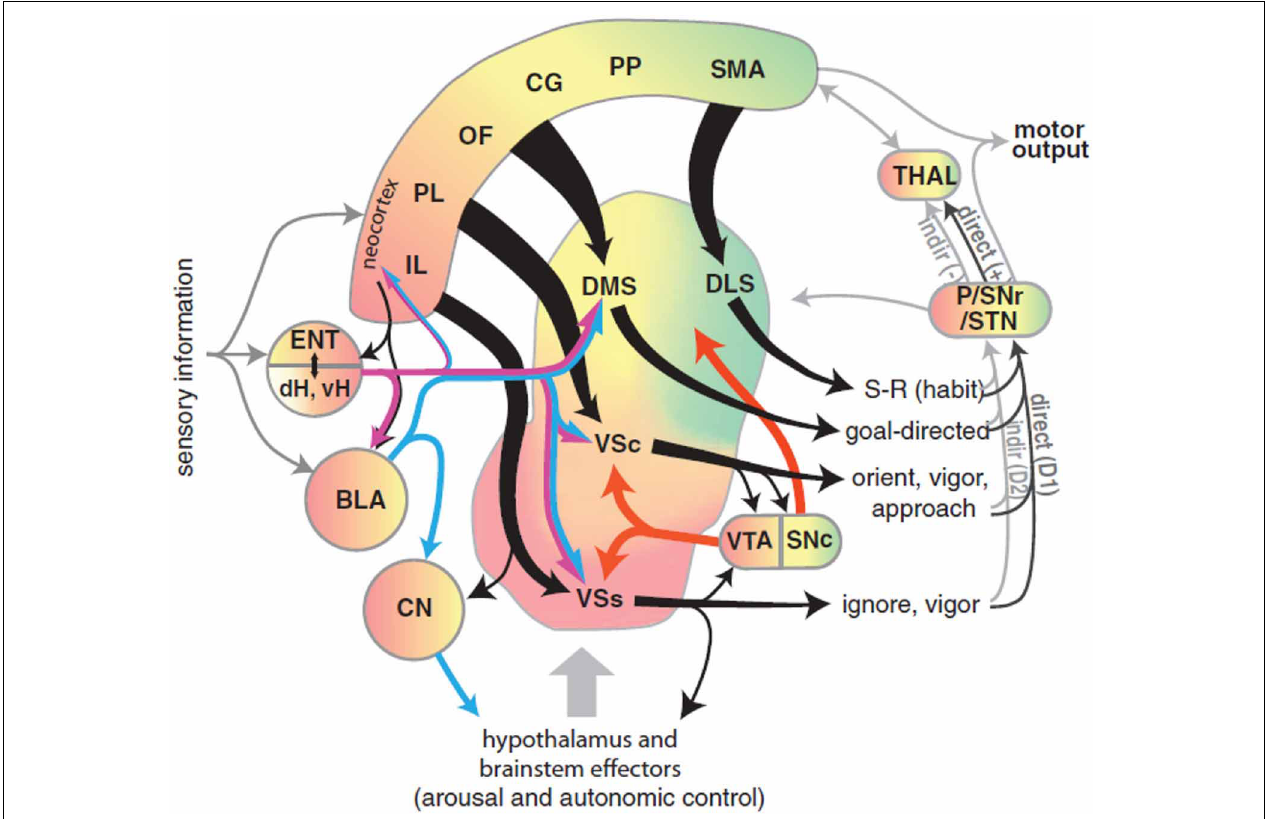
FIGURE 2 | Diagram of the rat brain illustrating a proposal on the role of DLS to select habits, of DMS to drive goal-directed behavior, and of NAcc to assign vigor to the performance of